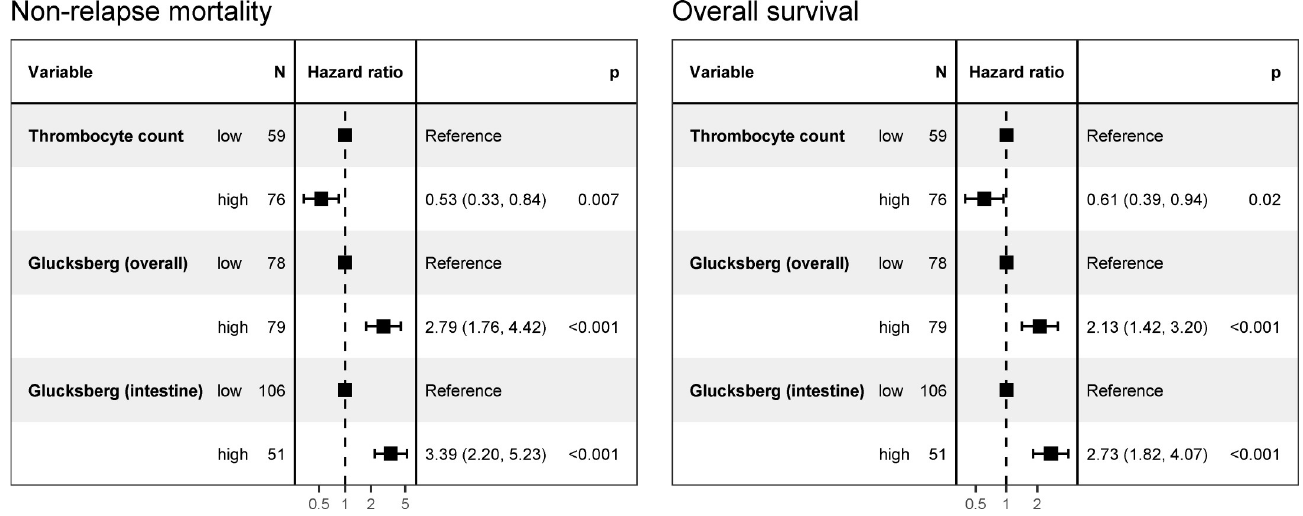
Fig 7. Univariate Cox regression analysis of non-relapse mortality and overall survival on thrombocyte count, Glucksberg grade of the graft-versus-host disease overall, and Glucksberg grade of the intestine.